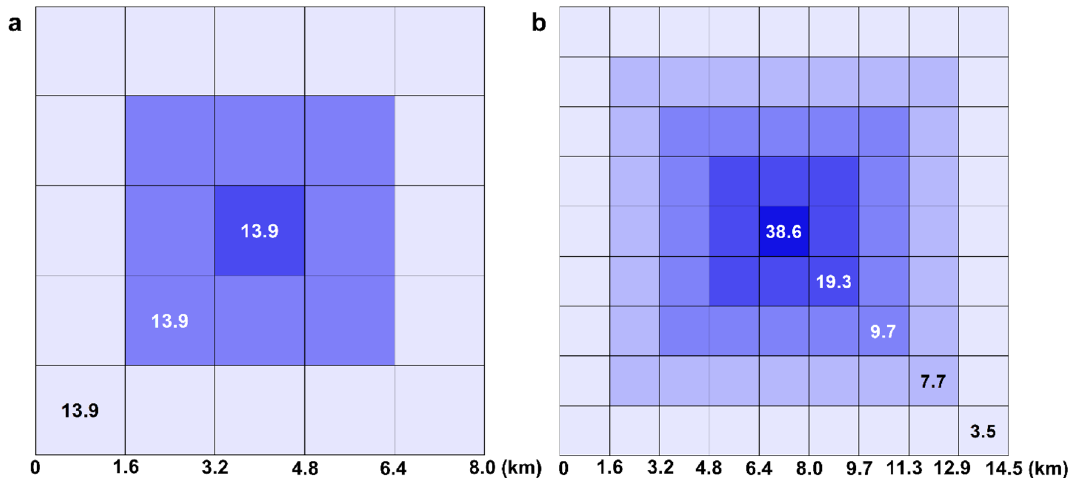
Figure 1. Examples of published delimiting survey trapping grids for: ( a ) The leek moth, with a uniform trap density, and ( b ) the Medfly, with variable trap densities. Each cell represents 2.59 km 2 (one square mile); the number in each cell shows approximate trap density (no. per km 2 ) and each color indicates a